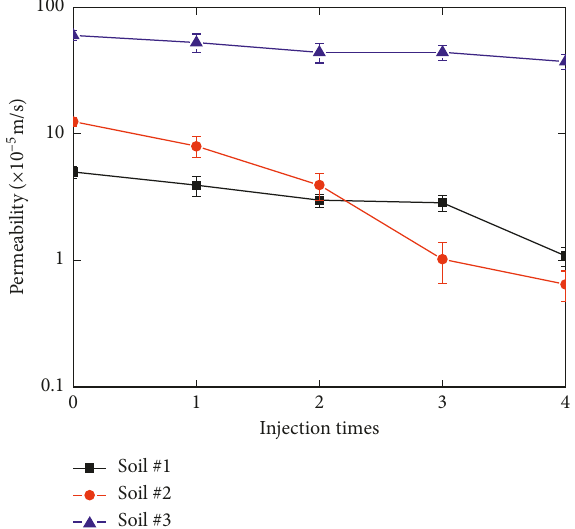
Figure 5: Soil permeability after each injection of the bacteria and cementation solution with different soil particle